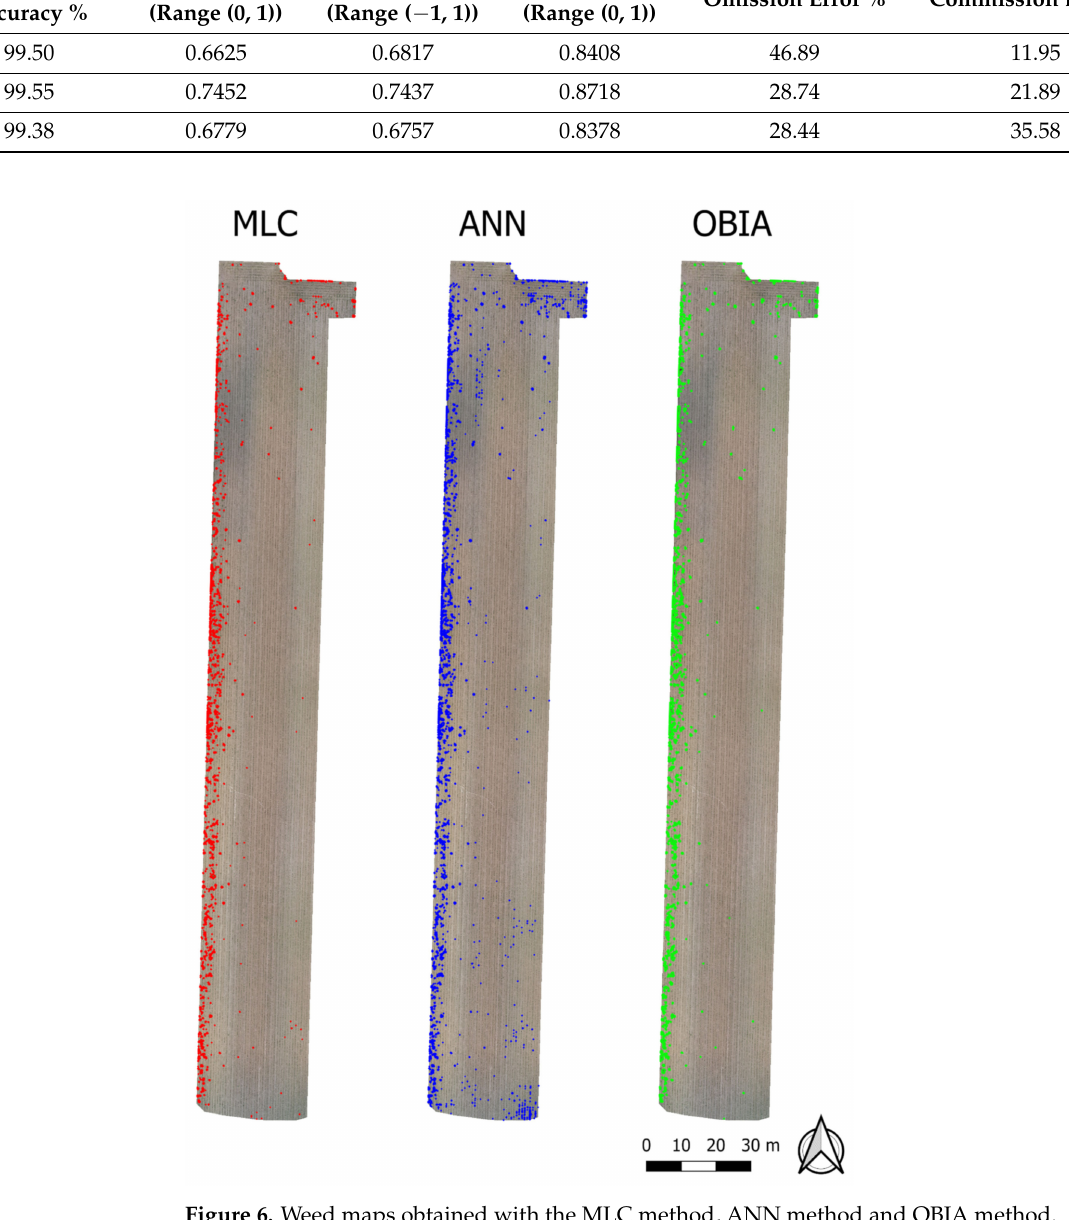
Figure 6. Weed maps obtained with the MLC method, ANN method and OBIA